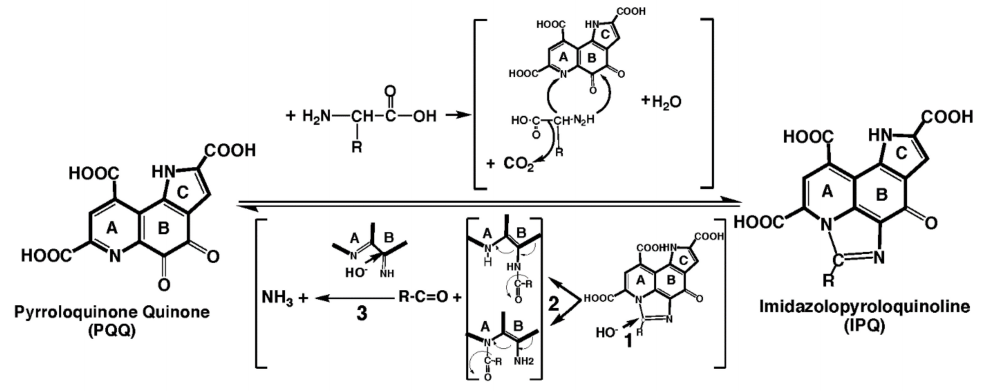
Figure 6. Imidazolopyrroloquinoline (IPQ). PQQ reacts with non − branched chain amino acids to form imidazole derivatives (IPQ), with or without retention of the amino acid sidechain (R). The reverse reaction (IPQ → PQQ) most likely results from a base-catalyzed opening of the imidazolium ring as a first step (1). Next, two intermediate forms are possible with the release of the imidazole carbon atom as an aldehyde moiety with or without an attached R group (2). Finally, there is a loss of the imine function that results from nucleophilic addition of OH − , isomerization and oxidation